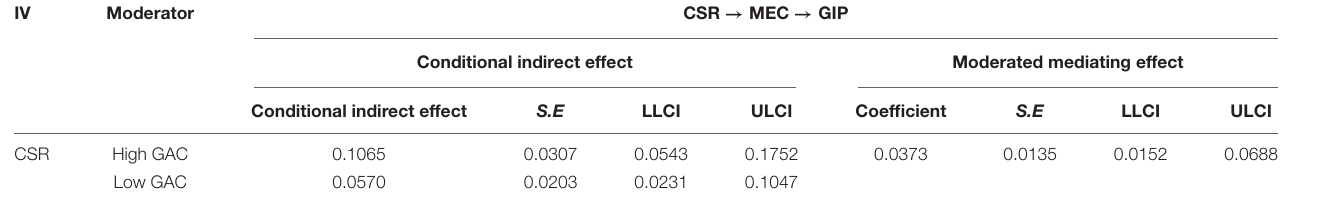
TABLE 7 | Moderated mediating effect.